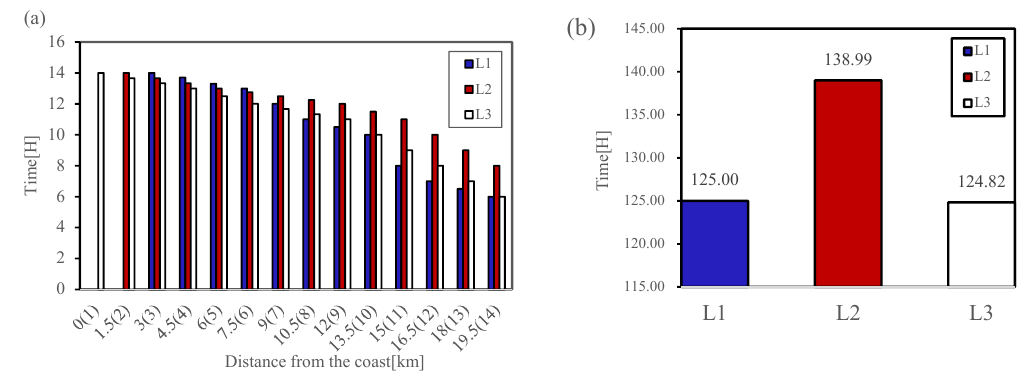
Figure 13. ( a ) The sea breeze duration at each point in the L1, L2 and L3 directions; ( b ) the sum of the sea breeze duration at all points in the L1, L2 and L3 directions.